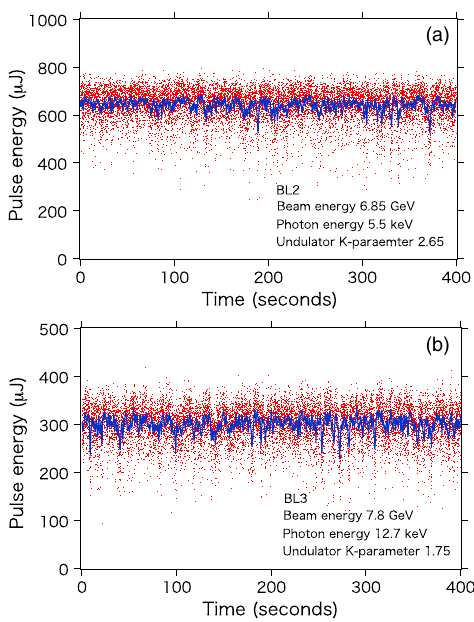
FIG. 11. XFEL pulse energies obtained in the multi-beam-line operation, (a) BL2 and (b) BL3. The photon energies are 5.5 keV at BL2 and 12.7 keV at BL3. The red dots represent single-shot results and the blue lines show averaged values over one second. The beam repetition is 60 Hz. The electron beam energy and K-parameter are 6.85 GeV and 2.65 for BL2 and 7.8 GeV and 1.75 for